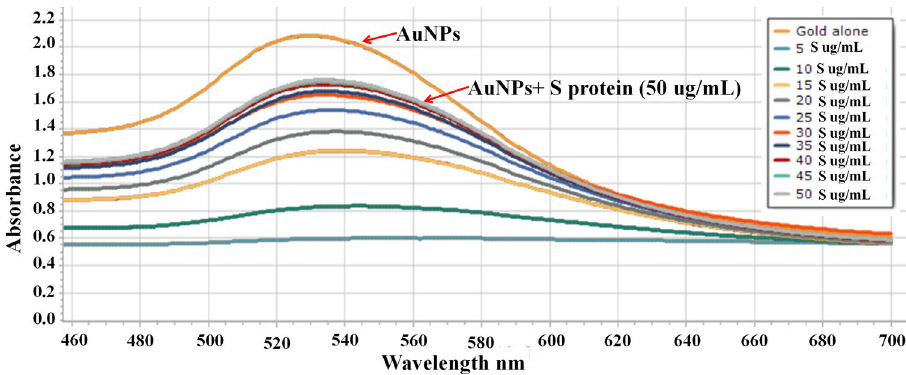
Figure 3. Spectral analysis of different protein concentrations that prevented AuNPs